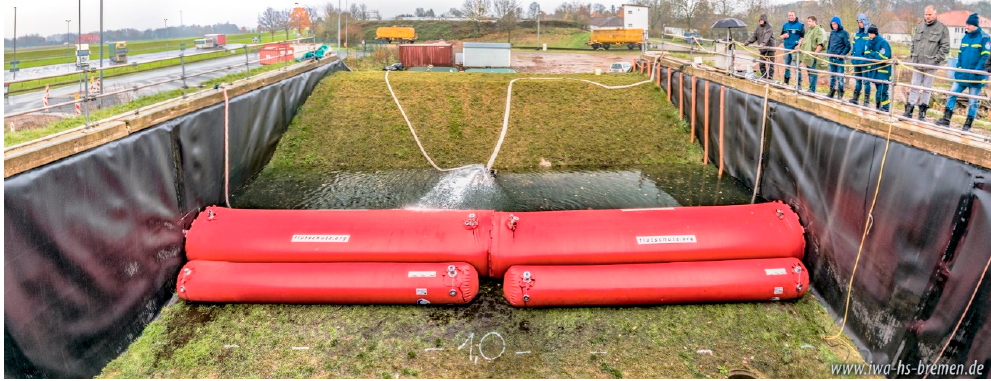
Figure 3. Impoundment using an SBRS—FLUTSCHUTZ-Doppelkammerschlauch—in the IWA test facility.